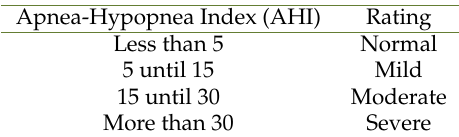
Table 1. Apnea-Hypopnea Index (AHI)